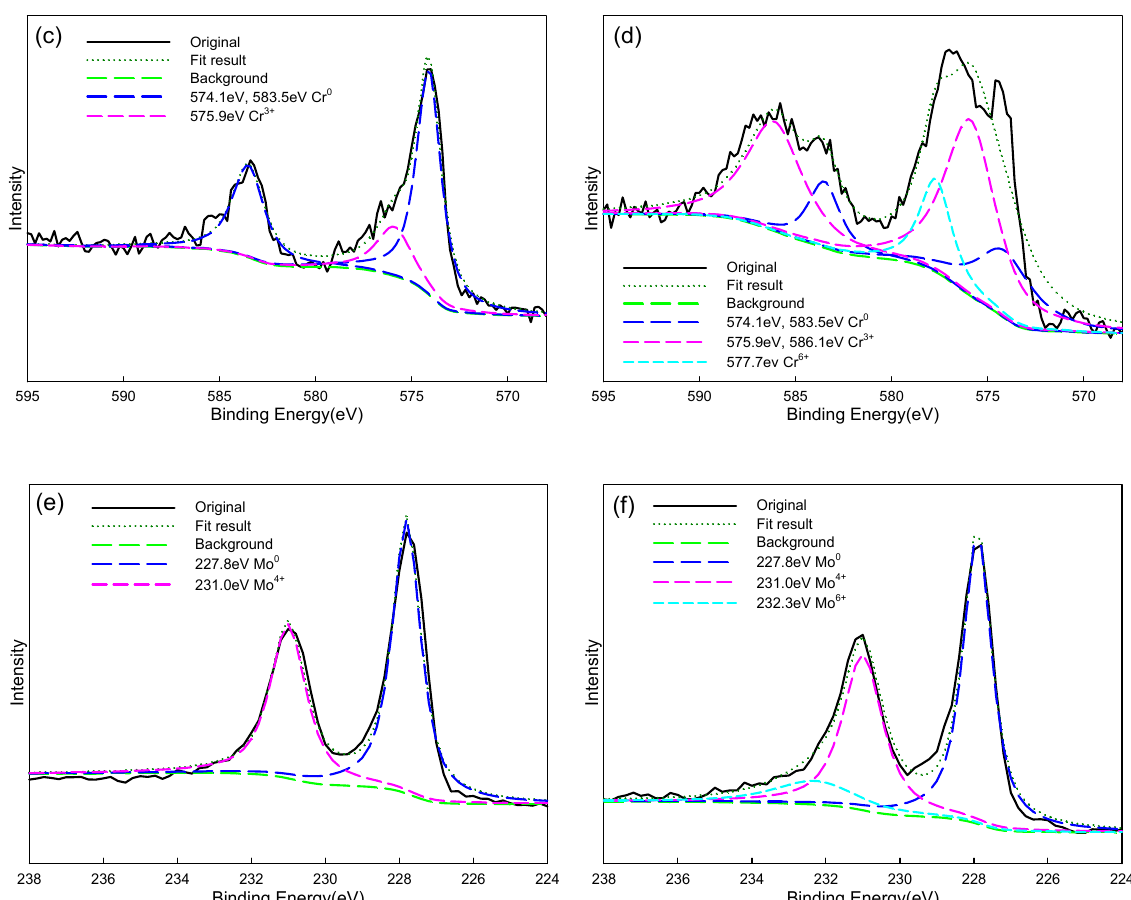
Figure 7. XPS spectra of passive films on the coatings initially ( a , c , e ) and after annealing at 700 °C ( b , d , f ).